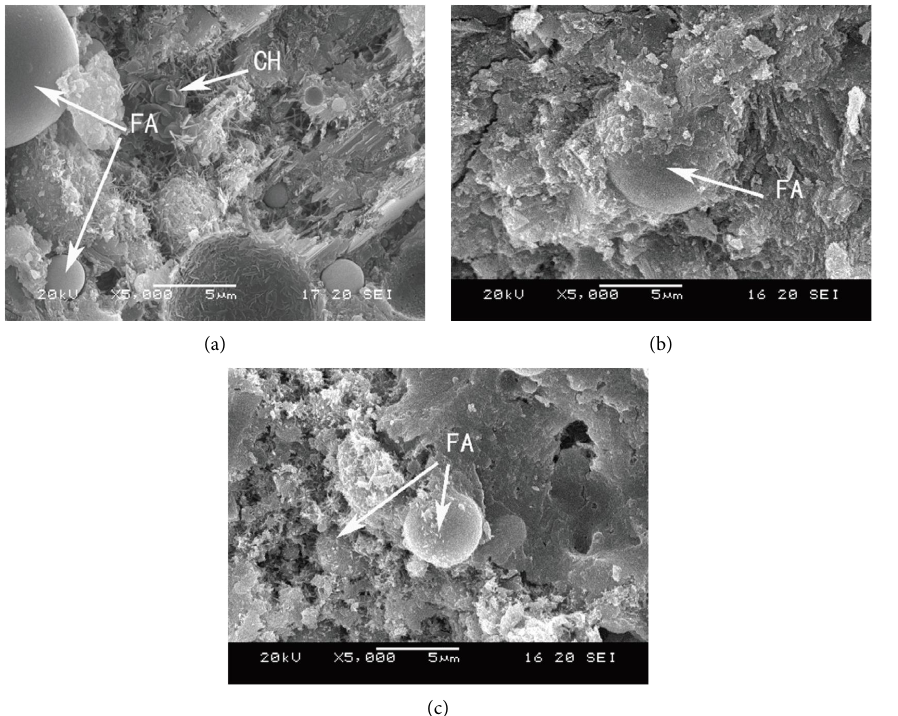
Figure 7: SEM images of mortars blended with MK and SF at 28d. (a) F50. (b) MK15. (c)